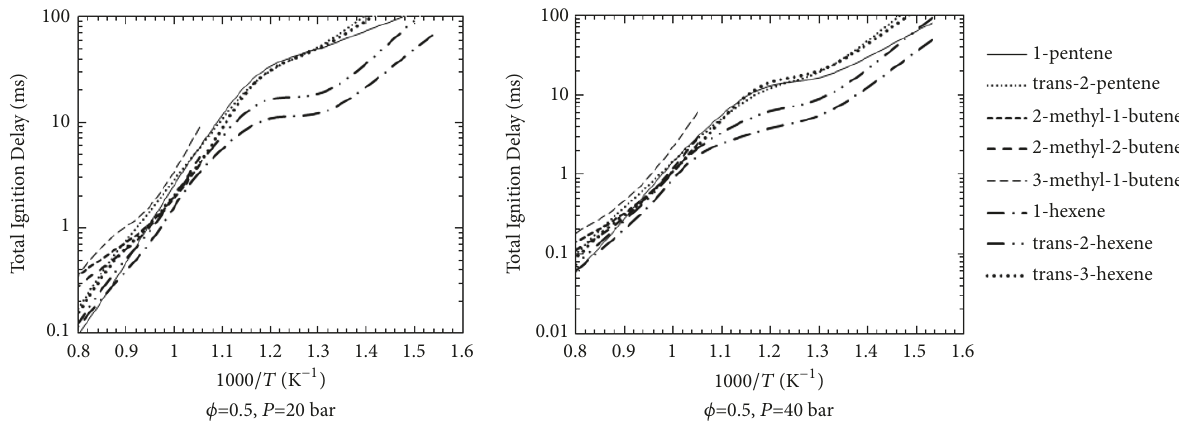
Figure 5: Simulated ignition delay times for the pentene and hexene isomers in air at pressures of 20 and 40 bar and an equivalence ratio of 0.5. Simulations were carried out using Mehl et al.’s [13] model in an adiabatic constant-volume